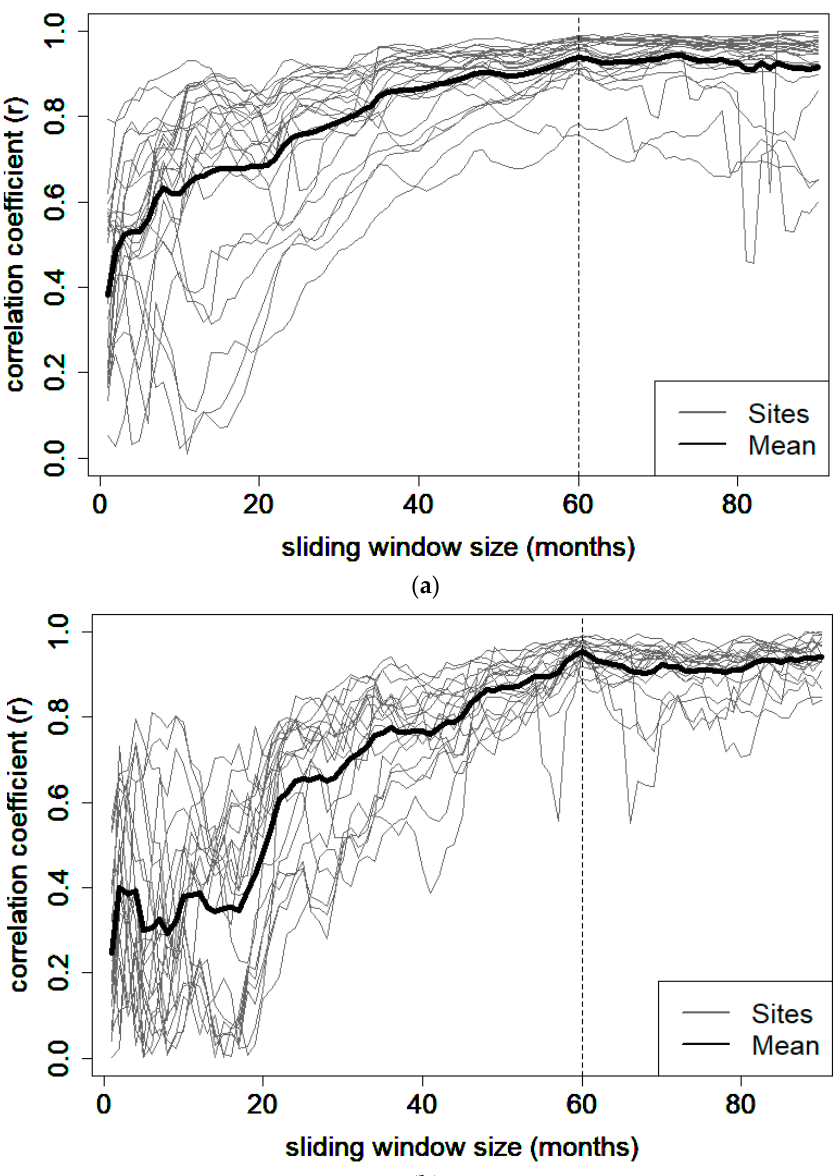
Figure 3. Resulting correlation magnitudes at sites along the coasts of North America (including the Great Lakes, Alaska, Hawaii, Puerto Rico, and Bermuda) and Mexico at which mean sea level correlates strongest with the ( a ) WHWP and ( b ) the EAWR using sliding windows sizes ranging from 1 to 90 months and lag time = 0 months over the time period of 1995–2018. The dotted lines indicate the selected optimal window